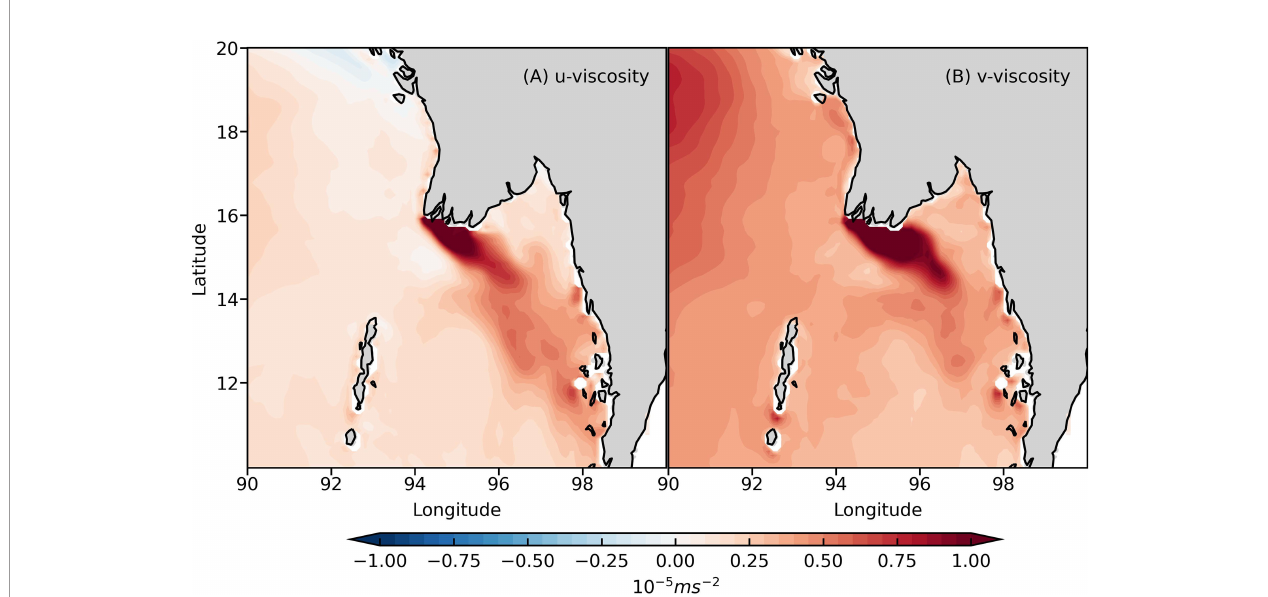
FIGURE 14 | Climatology of wind friction term from (A) u-momentum and (B) v-momentum at the surface in experiment IRFullW during summer